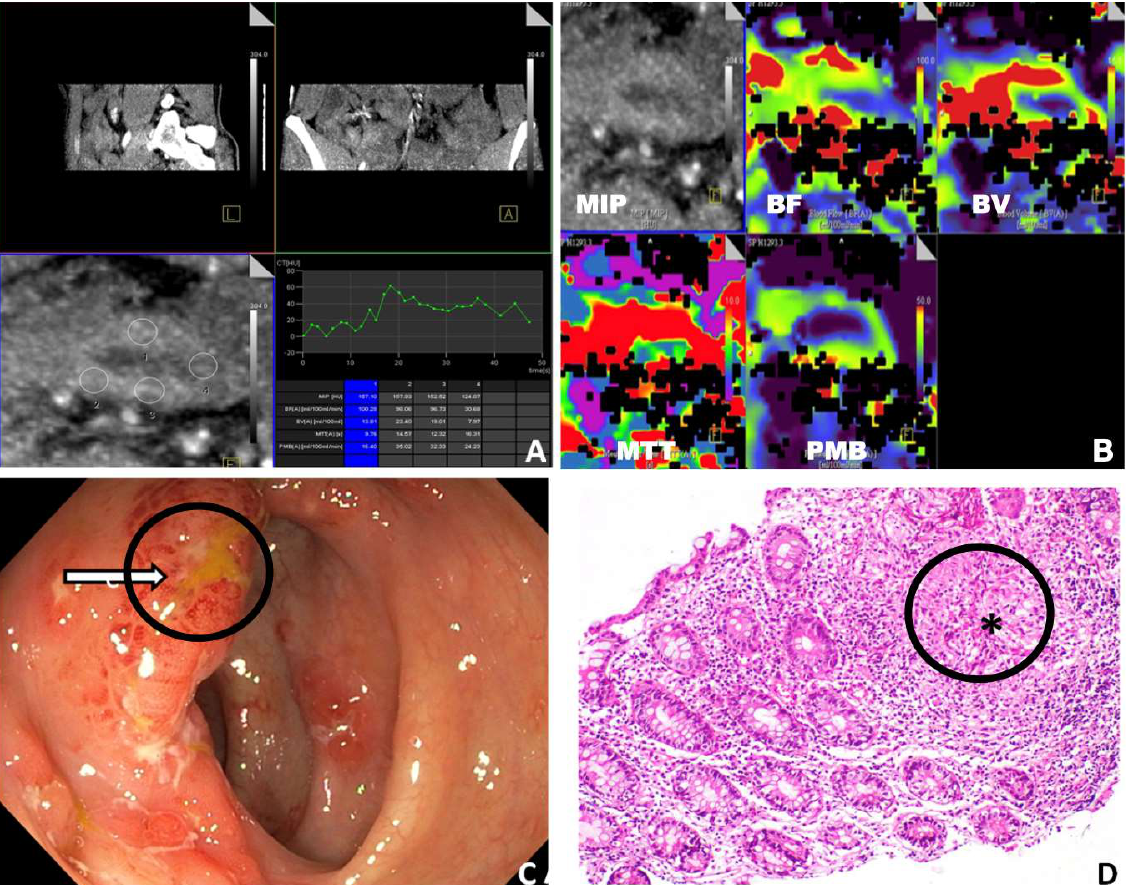
Figure 4. Case of gastrointestinal tuberculosis. ( A ) Post-processing perfusion CT images showing ROI placement and values of perfusion parameters. ( B ) Corresponding color-coded perfusion maps showing MIP, BF, BV, MTT, and PMB images. ( C ) Colonoscopic images of the same patient showing an oedematous and hyperaemic ileocaecal valve with a small ulcer (marked with a circle and an arrow). ( D ) Histopathological findings of the same patient: ileocaecal mucosal biopsy shows a non-caseating granuloma (marked with a circle and *) in the lamina propria (H&E X200) (MIP: maximum intensity projection; BF: blood flow; BV: blood volume; MTT: mean transit time; PMB: permeability; H&E: haematoxylin and eosin).